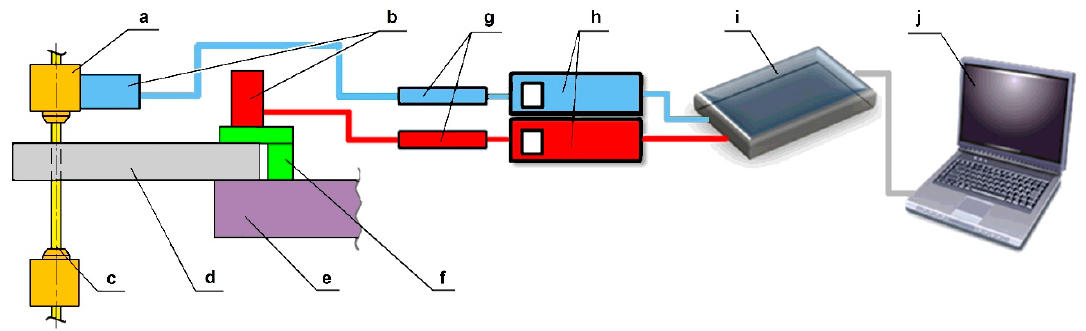
Figure 2. Principal scheme of the system of vibroacoustic monitoring of wire electrical discharge machining: ( a ) is a guide, ( b ) is accelerometers, ( c ) is a wire-tool, ( d ) is a workpiece, ( e ) is a working table, ( f ) is a fastening system, ( g ) is preamplifiers, ( h ) is amplifiers model VShV003 (OOO Izmeritel, Taganrog, Russia), ( i ) is an ADC E440 (L-card, Saint-Petersburg, Russia), ( j ) is a signal-recording device. The pulsed solid-state laser of diode pumping U15 (RMI, Moscow, Russia) was used for laser ablation of AISI 321 samples (160 × 100 × 5 mm) for better understanding the possibilities of in-situ monitoring and adaptive control during pulsed machining